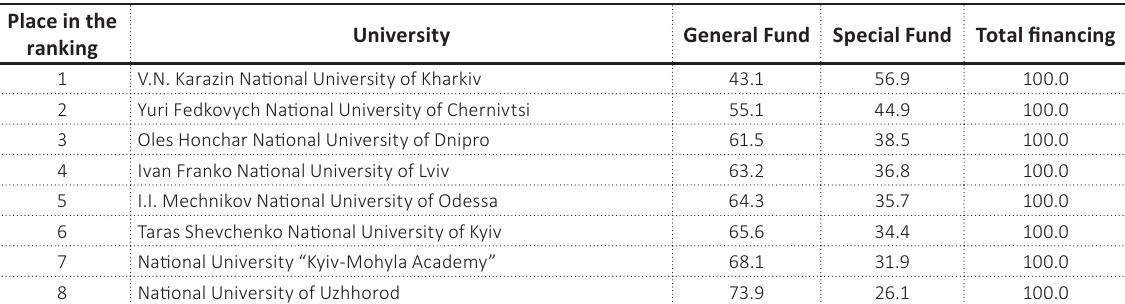
Table 2. Efficiency ranking of classical universities on the share of revenues to the special fund in 2010–2020 (average